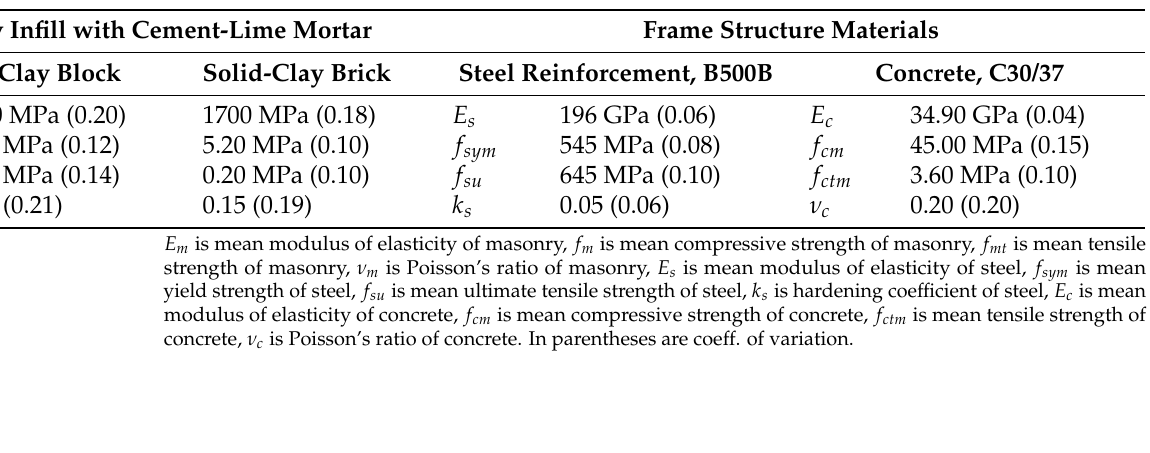
Table 1. Mean values and coefficients of variation (COV) of mechanical properties (masonry, steel reinforcement, and